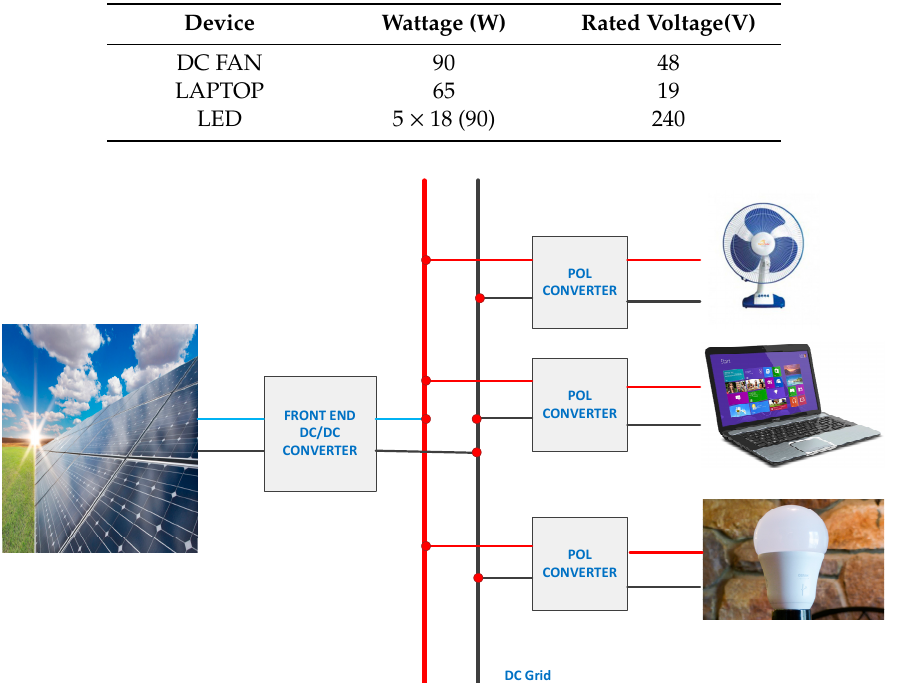
Table 1. Loads selected for the analysis of work.